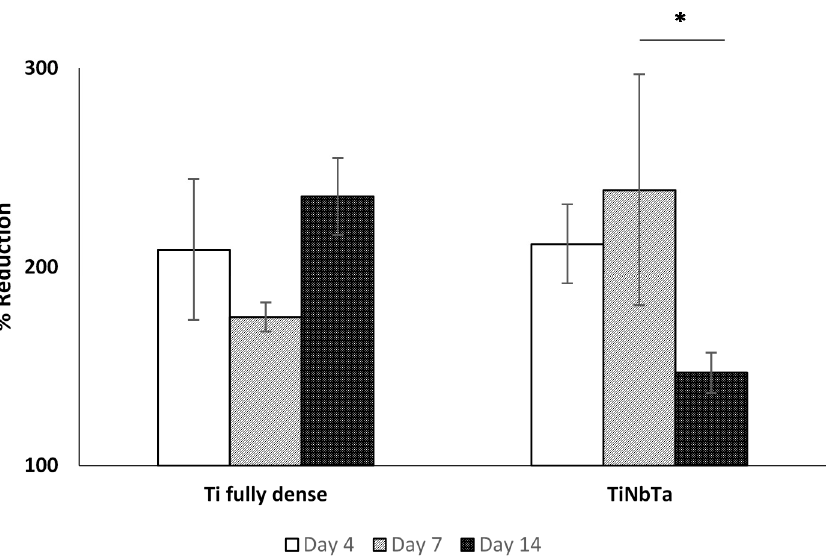
Figure 5. Cell viability of cultured cells from fully dense Ti or TiNbTa at 4, 7, and 14 days of cell growth. The results are presented as mean ± standard deviation, * p <